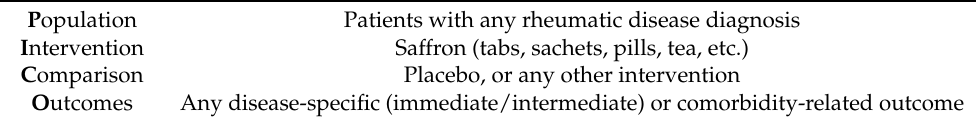
Table 1. PICO components of the study’s research